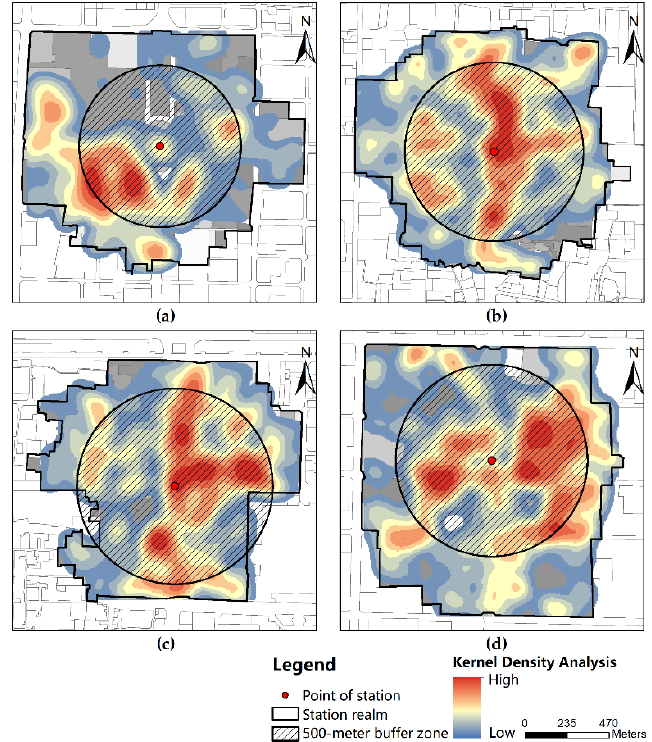
Figure 10. Temporal and spatial distribution of human activities in each study station realm: ( a )